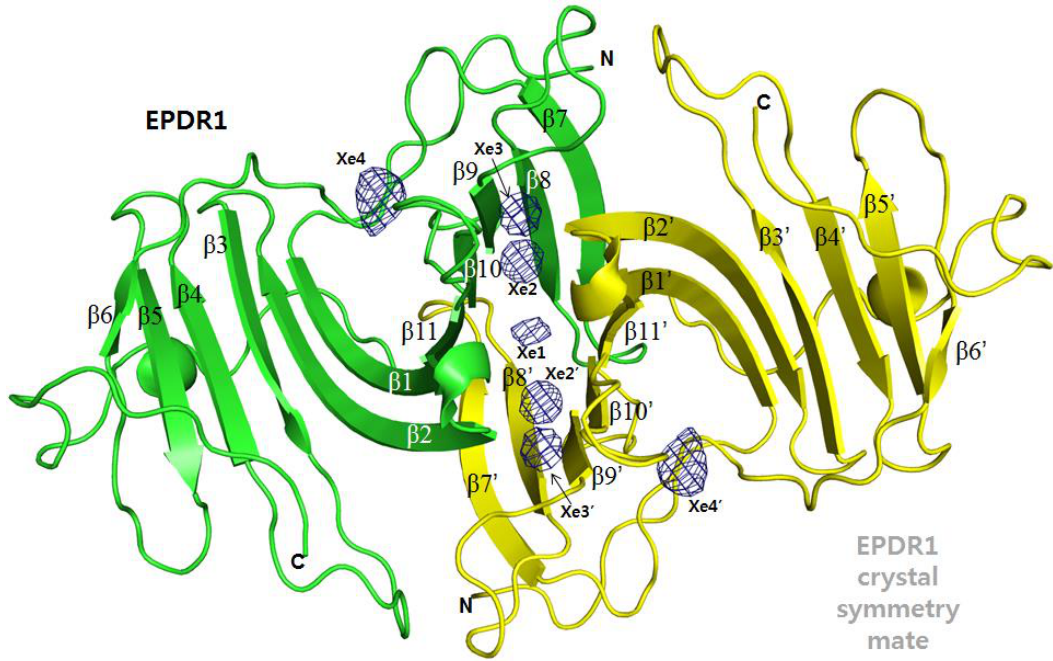
Figure 2. The locations of four Xe atoms. The overall locations of the four Xe atoms found in the frog EPDR1 (in the ribbon diagram) are shown on the dimeric structure formed by the crystal symmetry mate (in yellow). Except for Xe4, Xe1–3 are located in the dimeric interface. Xe1 is exactly located along the two-fold symmetry axis, hence being a special position (Xe1’ perfectly overlaps with Xe1.). The crystal symmetry locations of Xe2–4 atoms are indicted as Xe2’–4’. The OMIT Fo-Fc electron density map was contoured for the four Xe atoms at 3.6 σ.